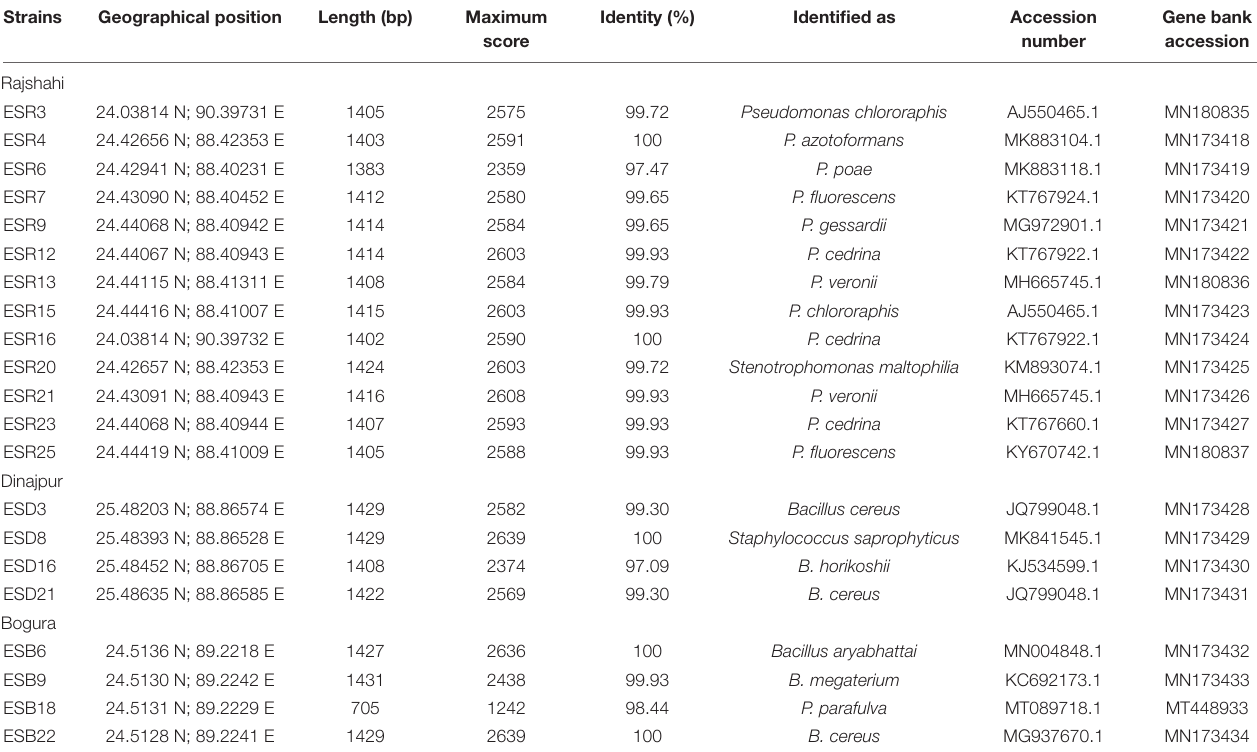
TABLE 1 | Identification of biofilm-producing rhizobacteria isolated from tomato rhizosphere grown in water stress-prone ecosystems of Bangladesh. Strains Geographical position Length (bp) Maximum Identity (%) Identified score